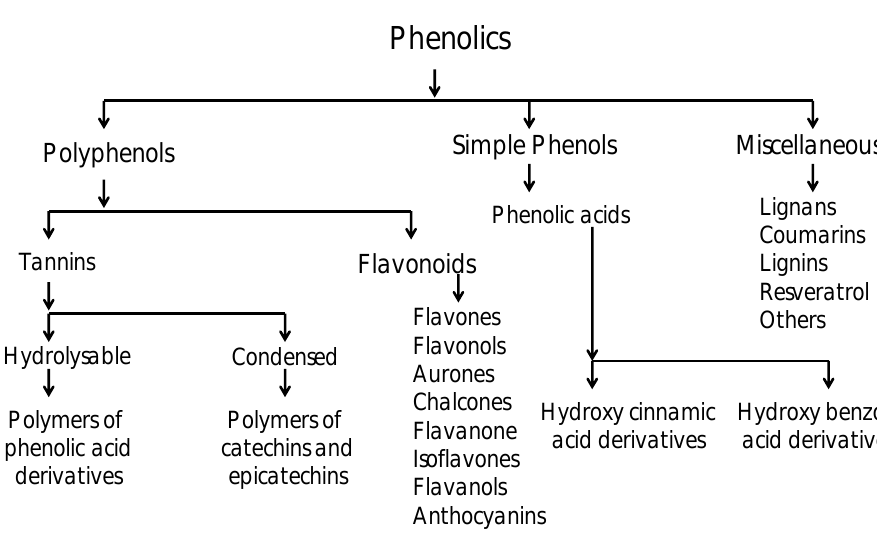
Figure 1 .General classification of plant phenolics, modified from